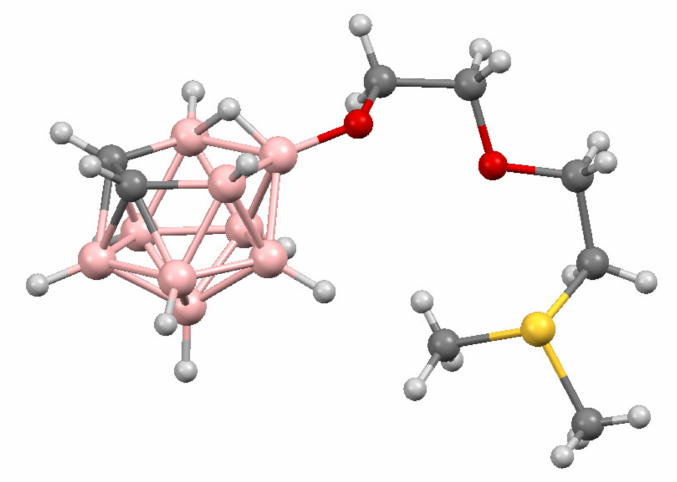
Figure 5. The molecular structure of 10-Me 2 SCH 2 CH 2 OCH 2 CH 2 O-7,8-C 2 B 9 H 11